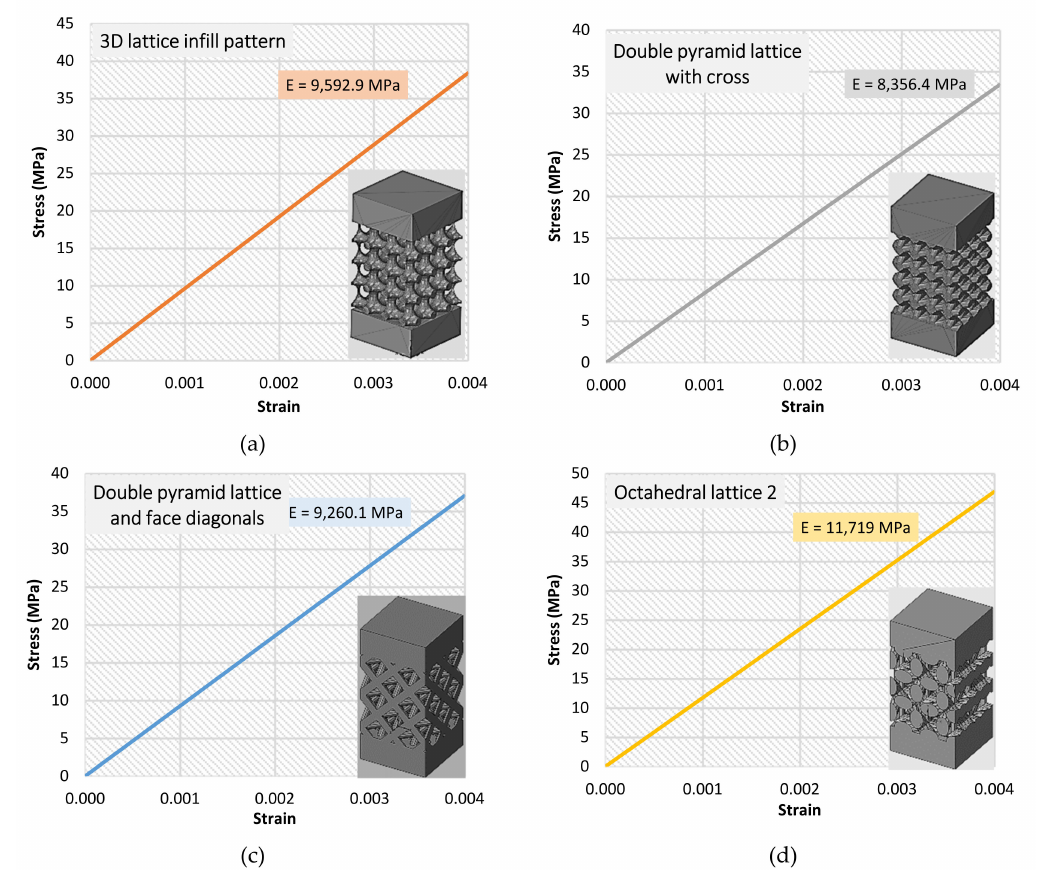
Figure 8. Stress–strain curves and the effective Young’s modulus calculated via numerical analysis. ( a ) 3D lattice infill pattern, ( b ) Double pyramid lattice with cross, ( c ) Double pyramid lattice and face diagonals, ( d ) Octahedral lattice 2.